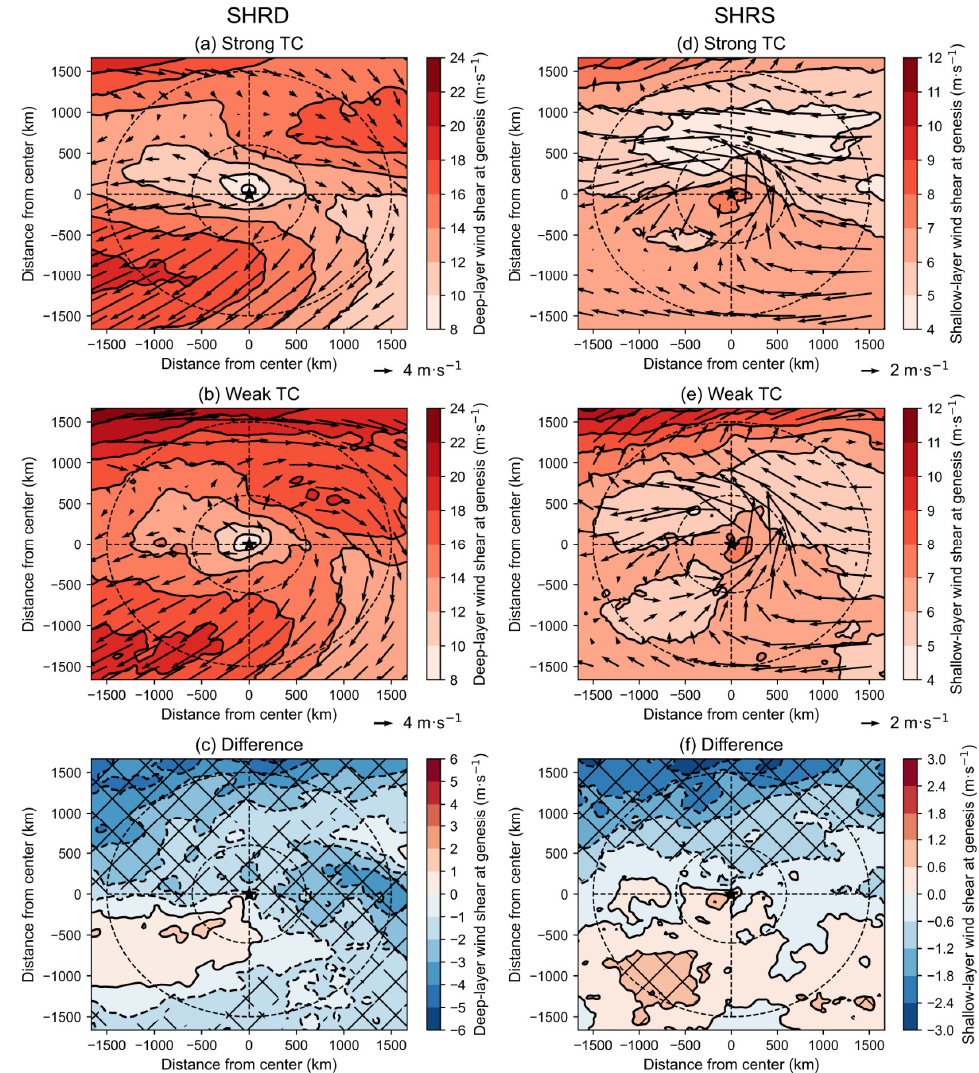
Figure 8. As in Figure 7, but for ( a – c ) deep-layer vertical wind shear (SHRD) of 850–200 hPa with wind vectors at 200 hPa (m s − 1 ) and ( d – f ) shallow-layer vertical wind shear (SHRS) of 850–500 hPa with wind vectors at 500 hPa (m s −1 ).